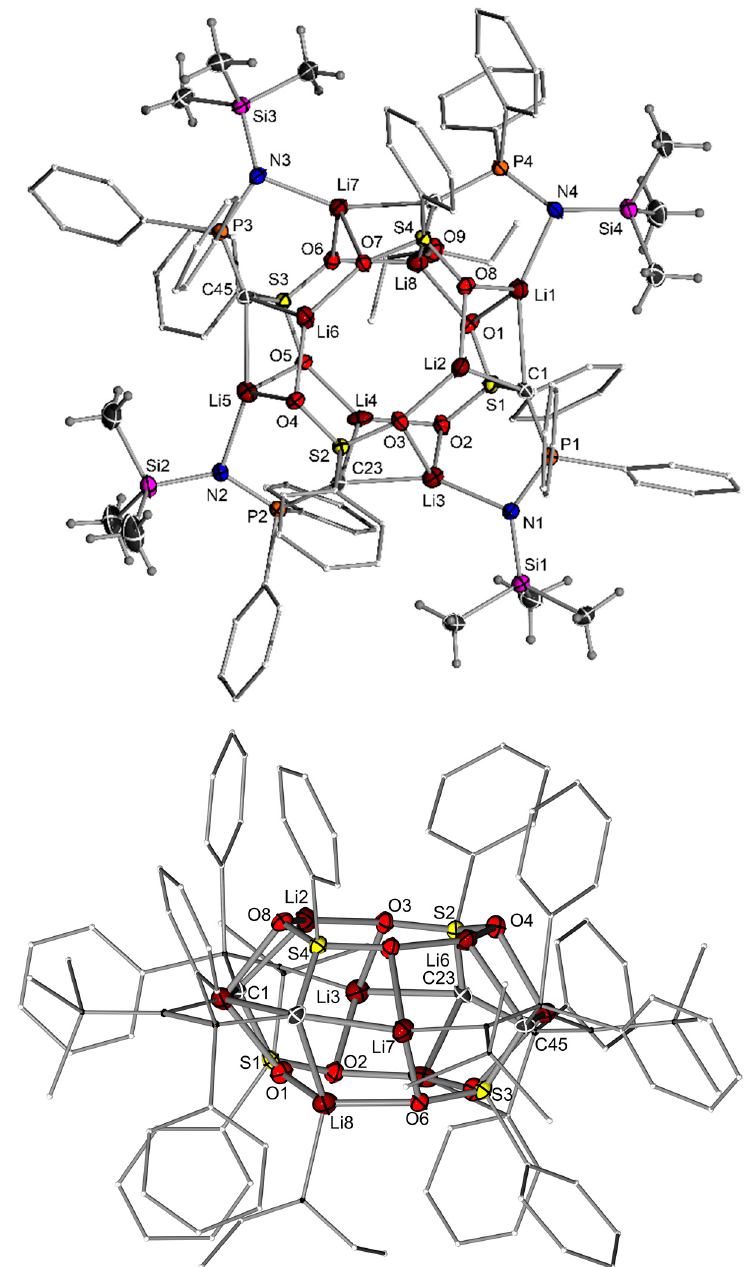
Figure 6. Displays of the crystal structure of methandiide 1-Li 2 . Ellipsoids drawn at the 50% probability level. Non-coordinating diethyl ether molecules and hydrogen atoms omitted for clarity. For bond lengths and angles, see Figure 7.